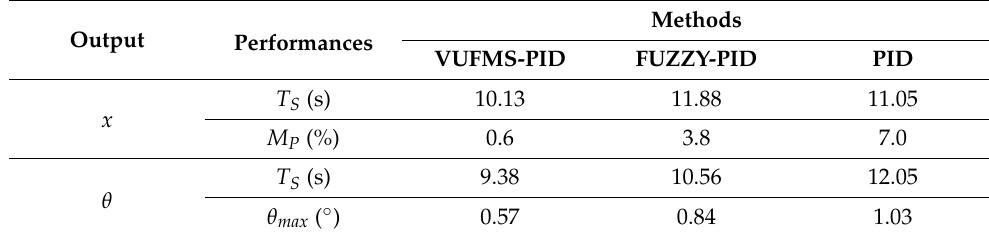
Table 8. Performances obtained using VUFMS-PID, FUZZY-PID, and PID controller under working condition 3.